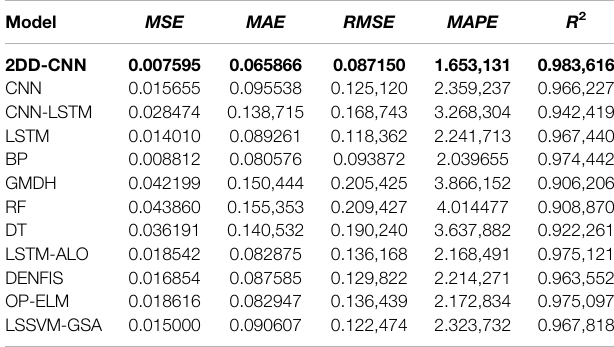
TABLE 1 | Comparison of evaluation indexes of model prediction